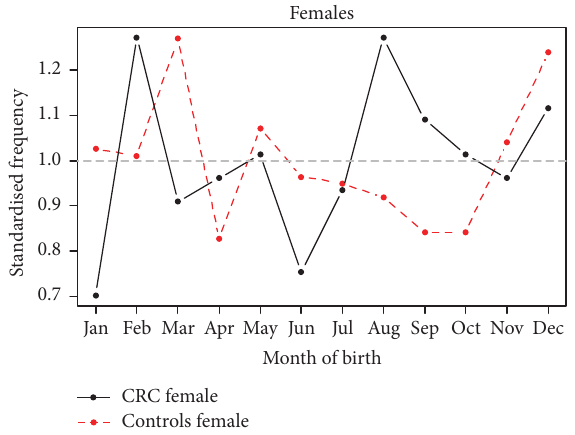
Figure 4: Detrended seasonal components by gender for female CRC and controls as a fraction of their means. An average increase of risk between the spring and the autumn peak of 16% for women is seen. The September peak remains in evidence but the trough appears to have shifted from March to